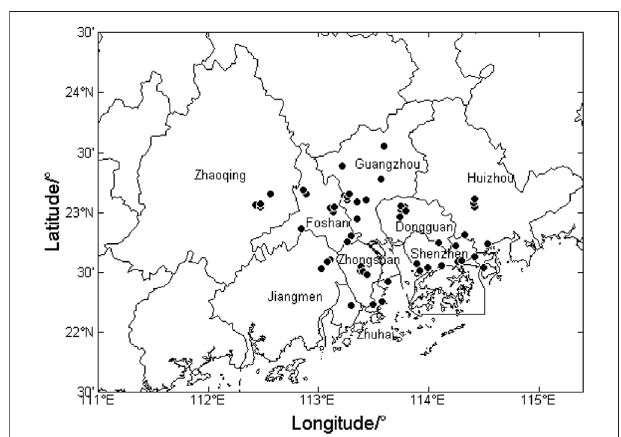
FIGURE 1 | Distribution of national control stations in the Pearl River